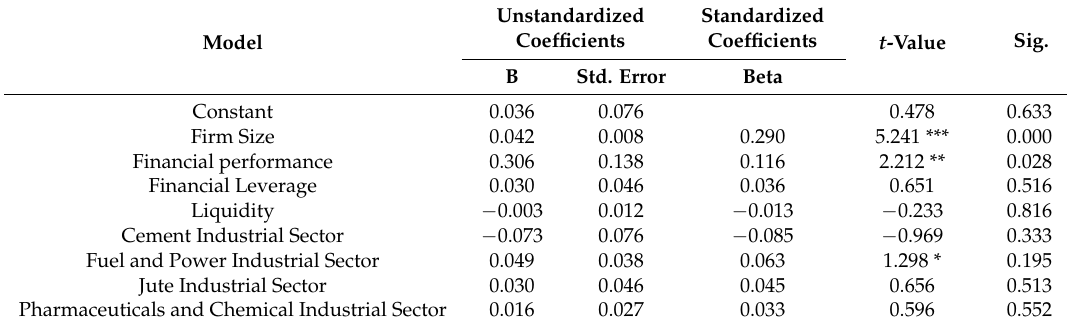
Table 4. The Level of Financial Disclosure and Firm Financial